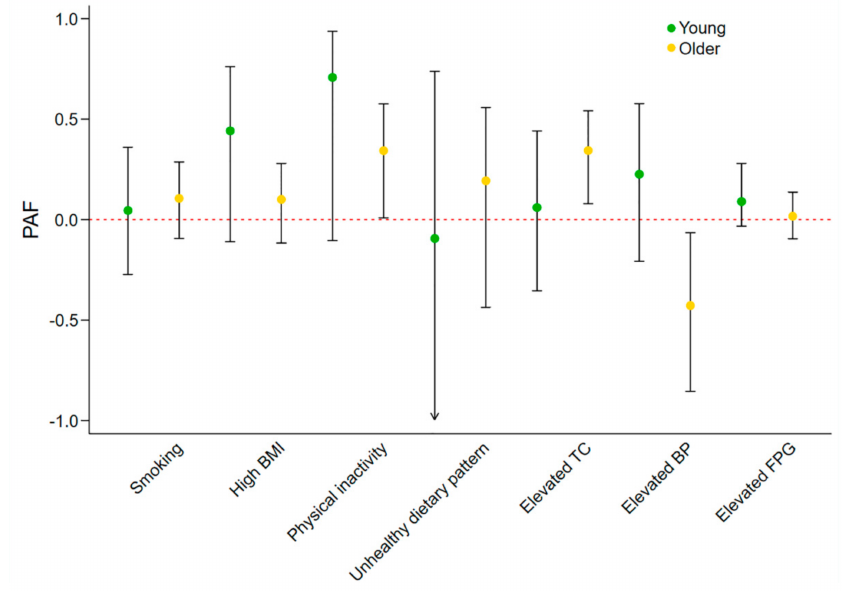
Figure 2. Adjusted PAFs of CVH metrics to IHD prevalence, stratified by age. Abbreviations: PAF, population attributable fraction; TC, total cholesterol; BP, blood pressure; FPG, fasting plasma glucose; CVH, cardiovascular health; IHD, ischemic heart